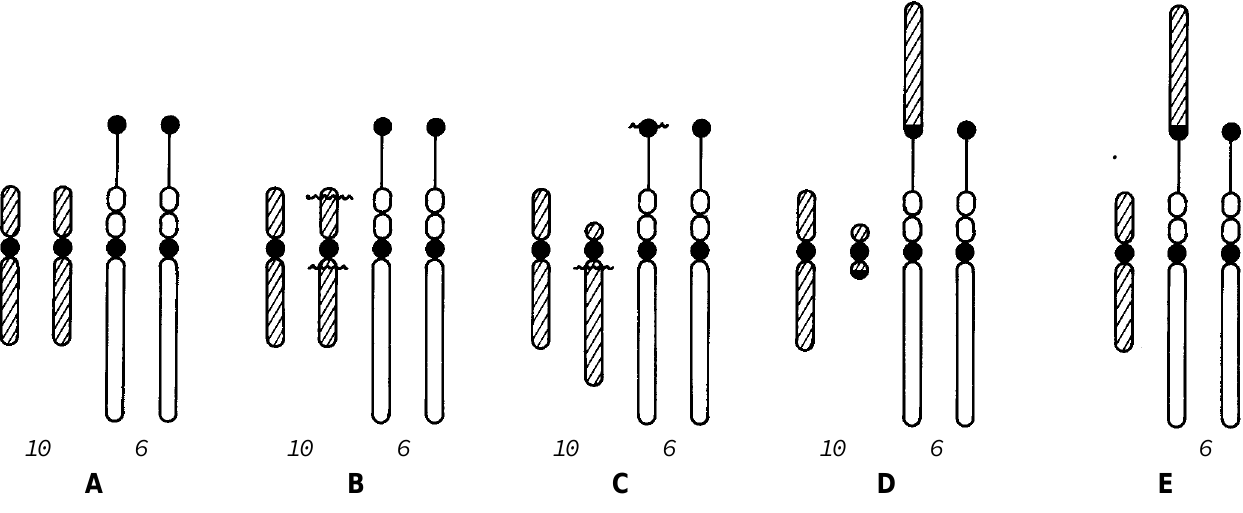
Figure 3 - Source of autosomal rearrangement. A = Chromosomes involved in rearrangement: the tenth submetacentric pair and the sixth submetacentric with constrictions in the short arm. B = Pericentric inversion in the tenth chromosome. C,D = Tandem translocation involving inverted chromosome of the tenth pair with the satellite from the short arm of sixth pair. E = Rearranged chromosomes showing a small submetacentric chromosome in the tenth pair, a large submetacentric chromosome with two secondary constrictions in the upper arm and a submetacentric chromosome with two constrictions in the lower arm. Small element is